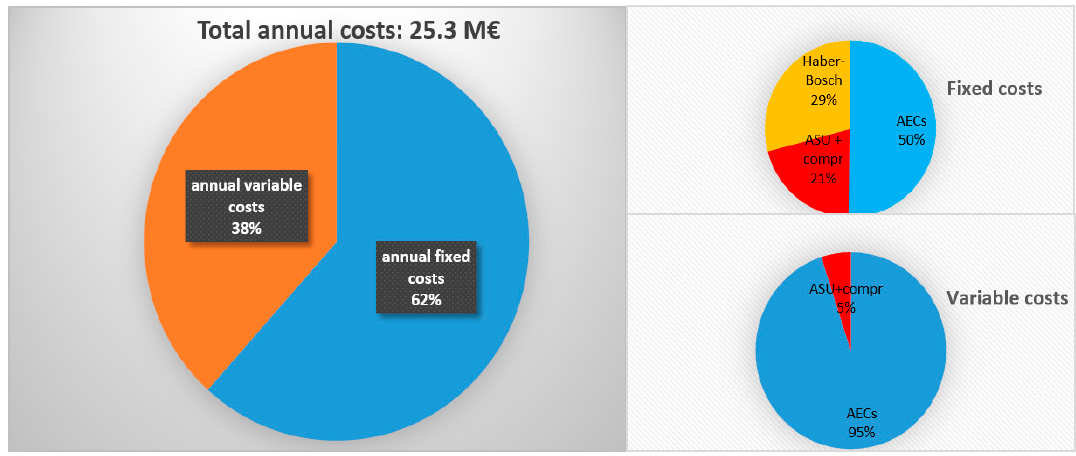
Figure 4. Total annual costs distribution ( left ) and detail of fixed and variable costs ( right ) for a 200 ton/day NH 3 plant.